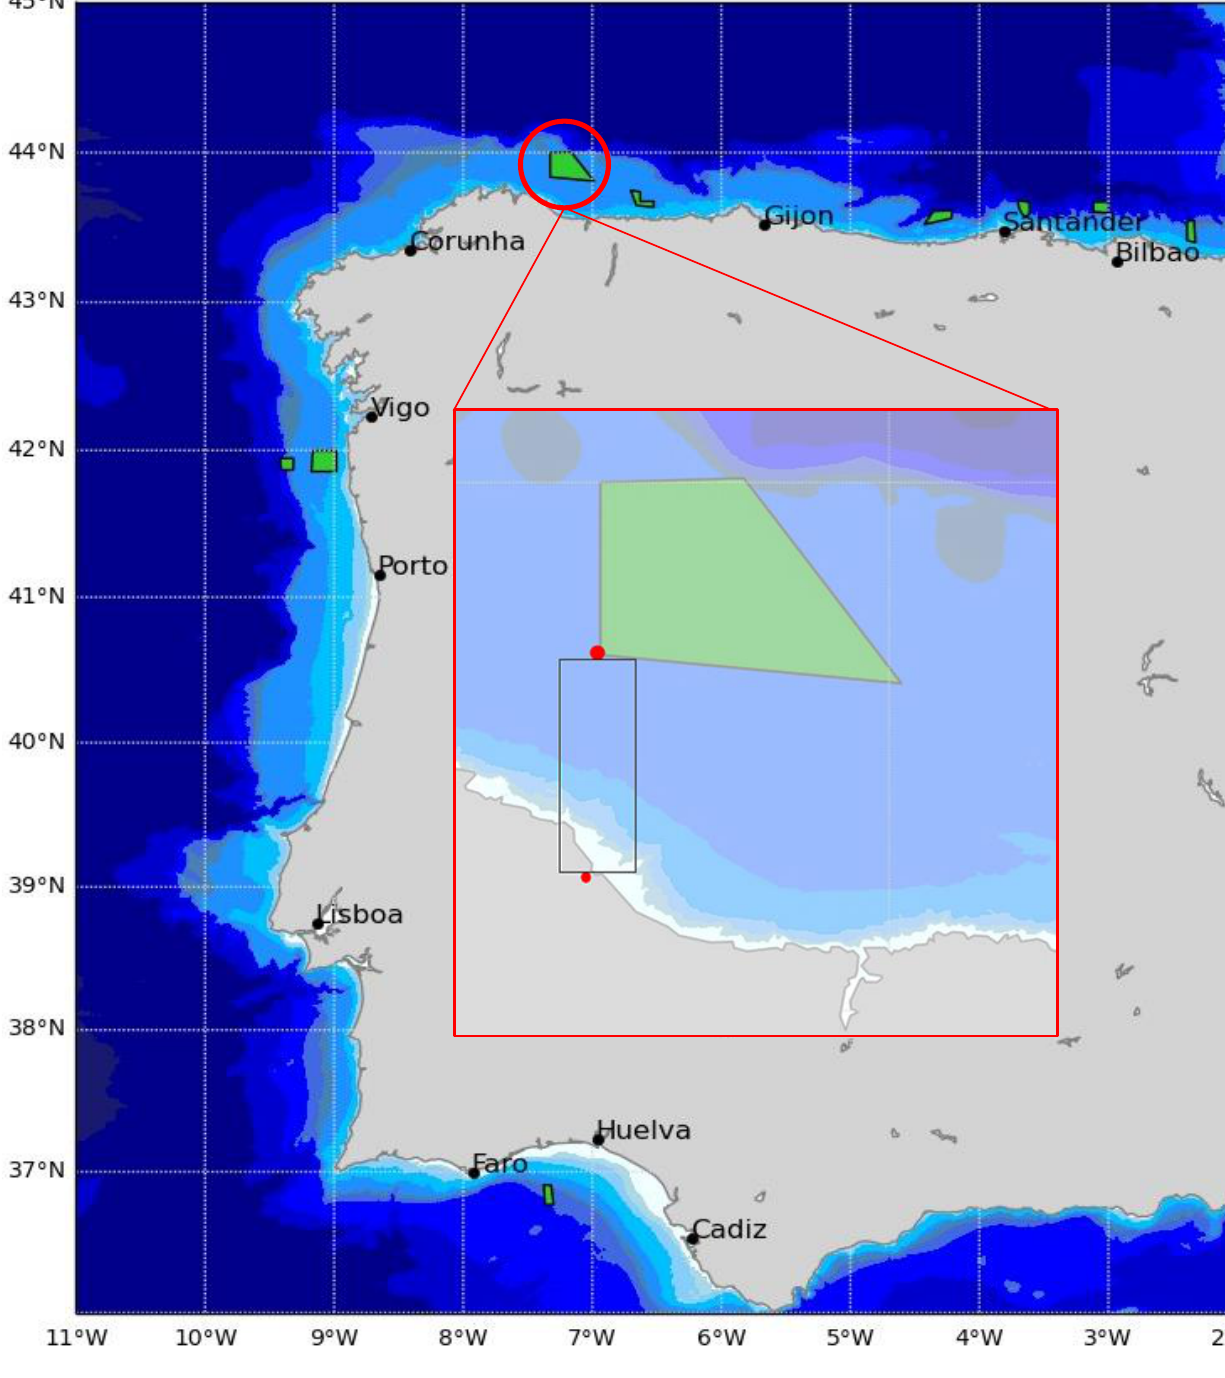
Figure 1. Ribadeo floating offshore wind farm (Lat: 44 Lon: − 7.3). Red points are the main substations onshore and offshore. The area between substations corresponds to the study area.